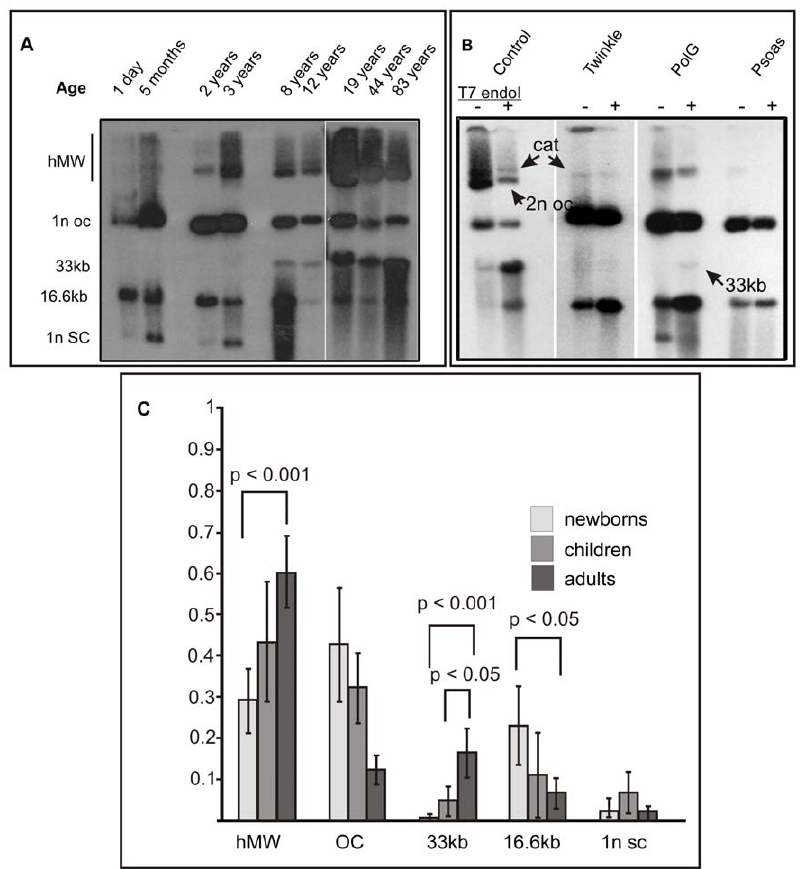
Figure 5. Human heart mtDNA topology changes in early childhood and in mitochondrial disorders involving mutations in Twinkle and PolG. The basis of the assignment of the different molecular forms is presented in [5]. (A) Newborns and young children have mainly monomeric open circular (1n oc), monomeric linear (16.6 kb) and monomeric supercoiled (1n sc) mtDNA molecules. Dimeric molecules, such as dimeric linears (33 kb) and complex mtDNA forms increase in early childhood. The quantities of different forms vary in adults and do not seem to depend on age or pathological status (data not shown). However, in an adult adPEO cases having Twinkle dup342-354 or with PolG (p.G848S/p. S1104C) compound mutation (PolG) the newborn-type mtDNA organization, including the monomeric supercoils are retained (B). T7 endonuclease I (T7 endoI) cleaves specifically branched DNA structures. Digestion of the heart DNA from the PolG patient shows that majority of the mtDNA molecules also in the branched structures are monomeric and there are around 14-fold less dimeric molecules than in the age matched control heart (male 44 years). In control heart, dimeric circular (2n oc) mtDNA molecules among the high molecular weight forms persist after T7 endoI, wheras they are not present in Twinkle adPEO patients and greatly decreased in the patient with mutant PolG. The other HMW forms being resistant to T7 endoI are catenanes (cat). As a comparison, in human skeletal muscle (ilio-psoas) there are very few T7 endo I sensitive molecules, showing that complex branched mtDNA forms are still present in the PolG mutant patient heart (See also Ref # 5 for the assignment of the different molecular forms of human heart mtDNA). (C) Phosphoimager quantification of different mtDNA forms in cardiac muscle from one-day old newborns, young children (2–8 years) and adults. Statistically significant differences in high molecular weight (MW) forms, dimeric and monomeric molecules were detected (p-values; Students t-test). It should be noted that linear molecules are likely to arise due to artefactual breakage of mtDNA and can vary in post mortem samples depending on sample